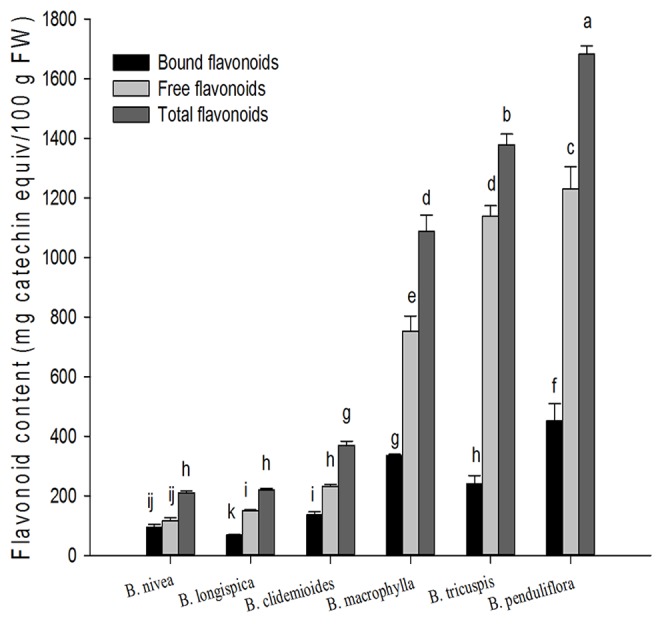
Flavonoid contents in six species of ramie leaves (mean ± SD, n = 3).Bars with no letters in common are significantly different (p<0.05).